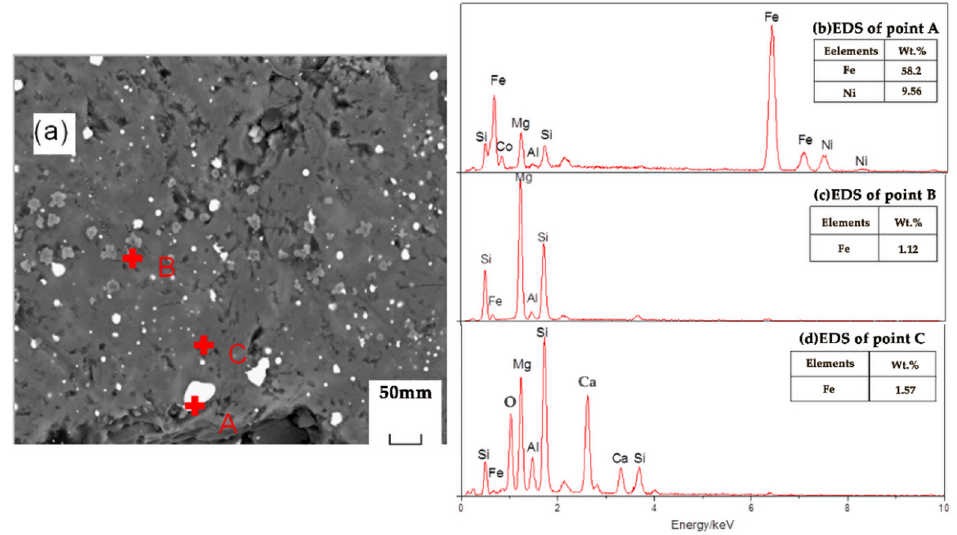
Figure 10. SEM/EDS analysis of reduction samples under the action of calcium fluoride; ( a ) scanning electron microscope image, ( b ) EDS spectrum of spot A in image ( a ), ( c ) EDS spectrum of spot B in image ( a ), ( d ) EDS spectrum of spot C in image ( a ).